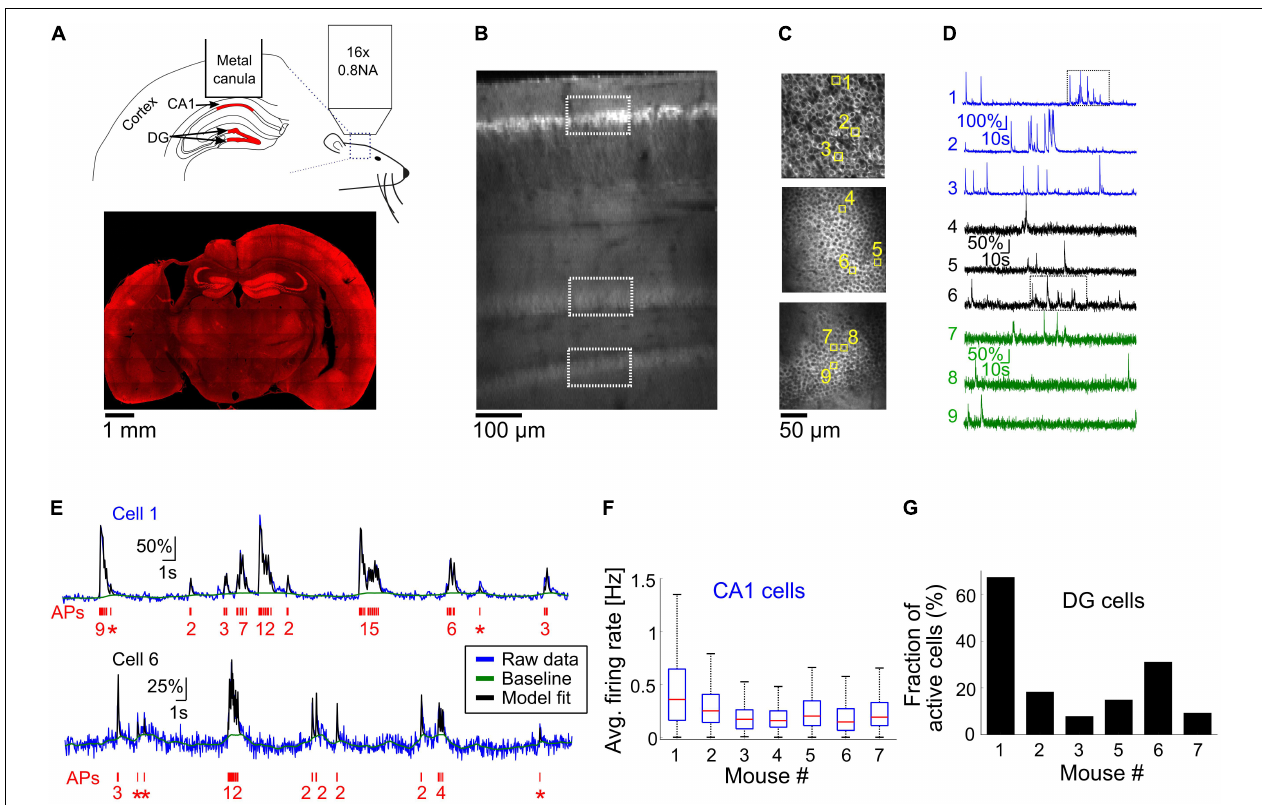
FIGURE 2 | Optical recording from mouse CA1 and DG regions of the hippocampus. (A) Top, schematic illustration of the mouse hippocampal recording experiments. We implanted metal cannulas with a glass bottom on top of the hippocampi of transgenic Thy-jRGECO1a mice to gain optical access to CA1 and DG neurons (shown in red). Hippocampus geometry was adopted from a mouse brain atlas (Dong, 2008). Bottom, a coronal section from the brain of mouse 1 shows the location of the hippocampal window and native jRGECO1a fluorescence signal throughout the brain. Note that some distortion to the brain tissue occurred when the metal cannula was detached from it. (B) In vivo dorsal-to-ventral view of a Thy1-jRGECO1a line 8.31 transgenic mouse expressing the red GECI jRGECO1a in the hippocampus 3 weeks after a craniotomy surgery. The tissue on top of the hippocampal formation was removed to expose the hippocampus and a z-stack series of two-photon microscopy images shows CA1 and DG regions. White rectangles indicate the location of the CA1 and DG (upper and lower blades) projection neurons, labeled by jRGECO1a. (C) Images of CA1 pyramidal cells (top image) and DG granular cells from the upper and lower blades of DG (middle and bottom images, respectively), corresponding to the respective rectangles shown in panel (B) . (D) (cid:49) F/F 0 traces of the nine cells highlighted with yellow squares in panel (C) . Note the differences in firing pattern and amplitude between the CA1 and DG cells. (E) Model fit (Deneux et al., 2016) (black line) to the raw fluorescence signal (blue line) of cells one and six [upper and lower traces, respectively, corresponding to the rectangles shown in panel (D) ] to extract the baseline signal (green line) and AP firing (red, bottom, single AP events are represented with asterisks). The model was fed with jRGECO1a biophysical parameters (Dana et al., 2016), and showed good agreement to the recorded data from both CA1 (top) and DG (bottom) neurons. (F) Summary of average firing rates of all recorded CA1 pyramidal cells from seven mice before the initiation of cuprizone diet (328–623 cells from a single recording session for each mouse, 3,167 cells total). Red lines correspond to medians, blue boxes show the 25th–75th percentile range, whisker length is the shorter of 1.5 times the 25th–75th range or the extreme data point. Outliers are not shown. (G) Fraction of active DG neurons from all recorded DG neurons from six mice before the start of cuprizone diet (470–997 cells from a single recording session for each mouse, DG cells of mouse 4 were not visible, 3,113 cells